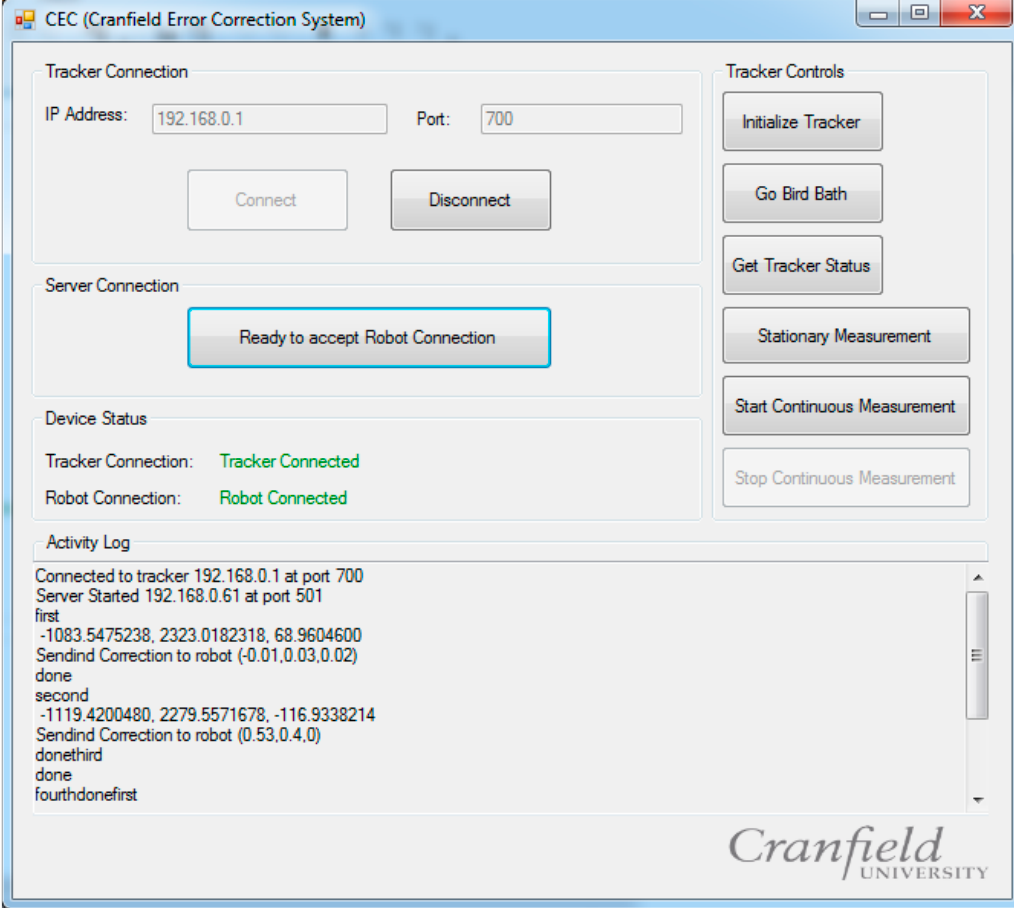
Figure 4. CEC for UR5 for static error correction.